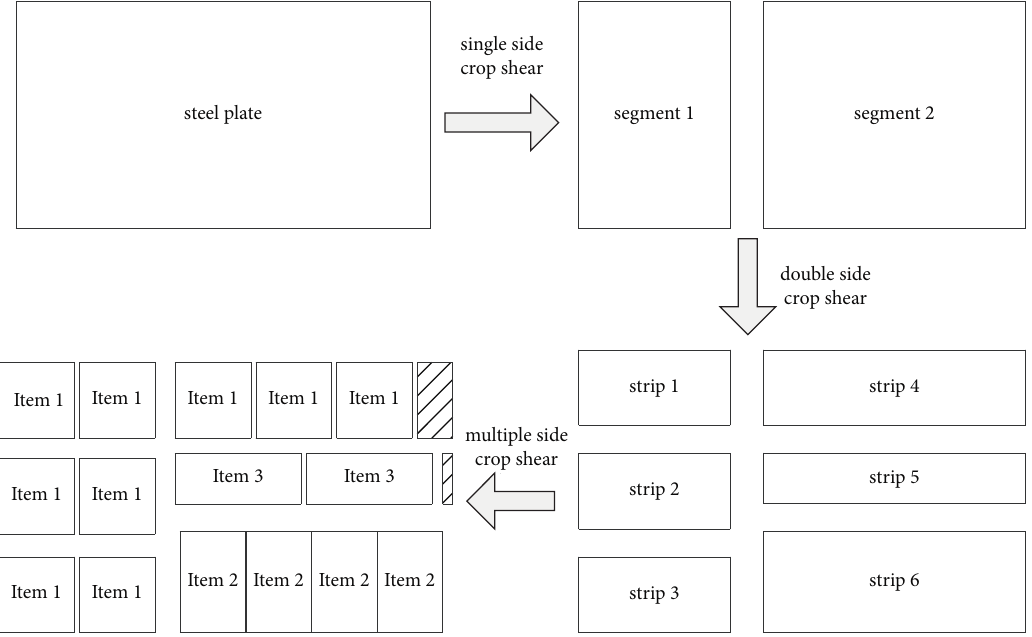
Figure 4: Cutting process for steel